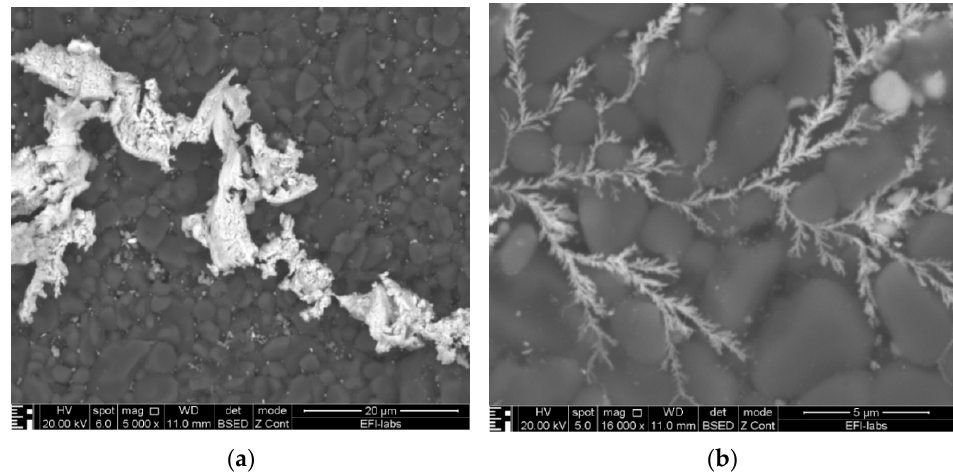
Figure 7. Close-up SEM micrographs of the dendrite structure: ( a ) rough and ( b ) very fine line Scheme 10 V bias.